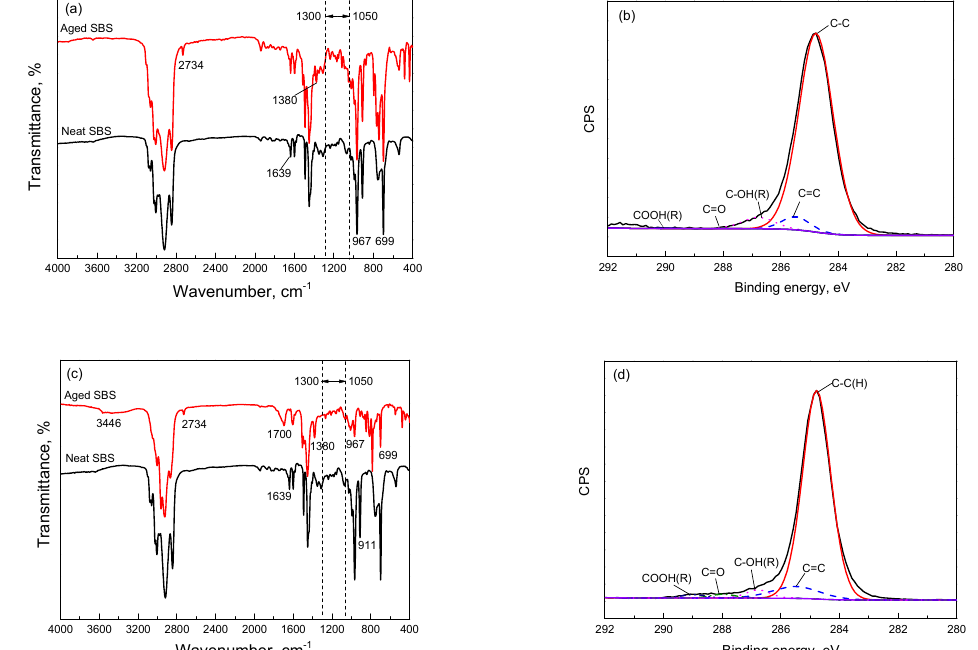
Figure 2. Fourier transform infrared spectroscopy (FTIR) and X-ray photoelectron spectroscopy (XPS) C1 spectra of ( a , b ) aged SBS exposure at 150 °C for 3 h with an oxygen flowrate of 1 L/min and ( c , d ) aged SBS exposure at 180 °C for 3 h with an oxygen flowrate of 1 L/min.